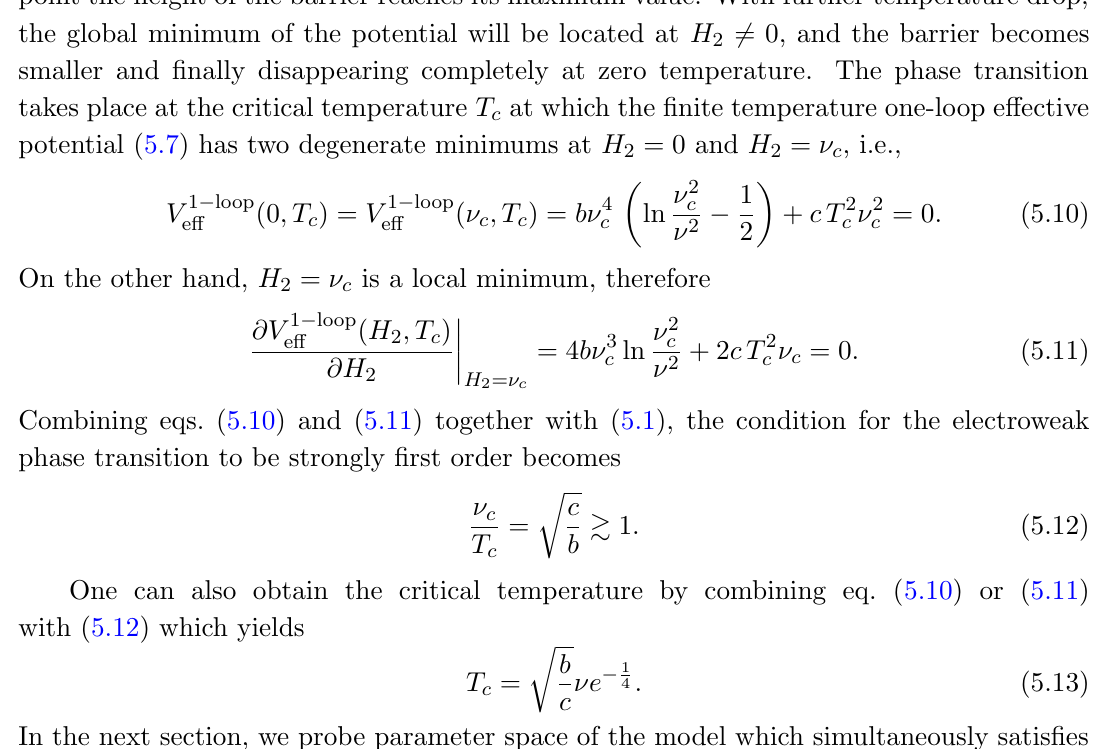
Figure 4 . The behavior of the (cid:12)nite temperature one-loop e(cid:11)ective potential V 1 (cid:0) loop various temperatures. The secondary minimum becomes degenerate with the original one at a critical temperature T c = 158